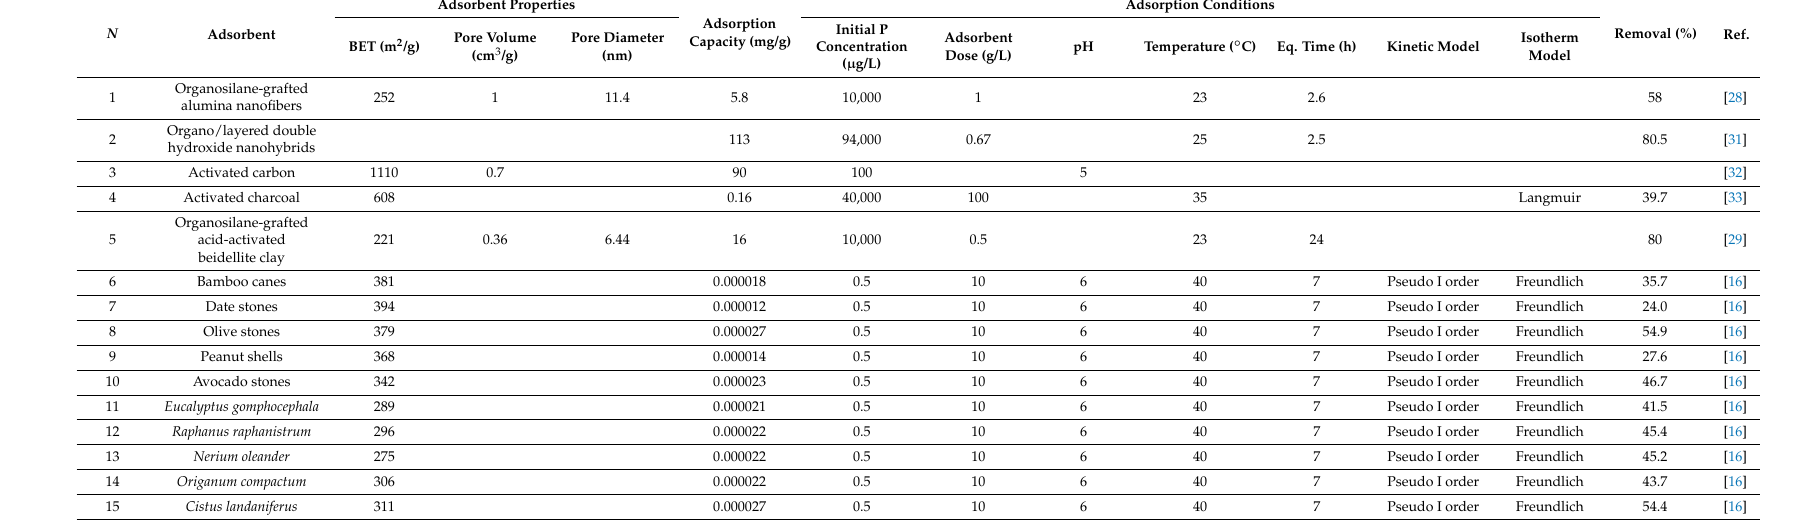
Table 2. Nanofibrous adsorbent properties and adsorption conditions for the removal of Alachlor. BET: specific surface area.